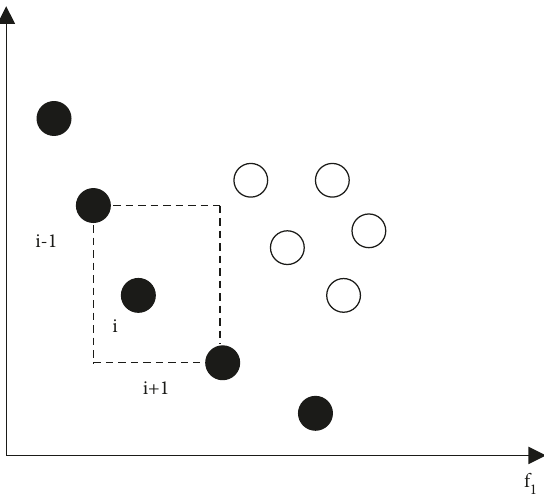
Figure 2: Congestion degree of the individual i .